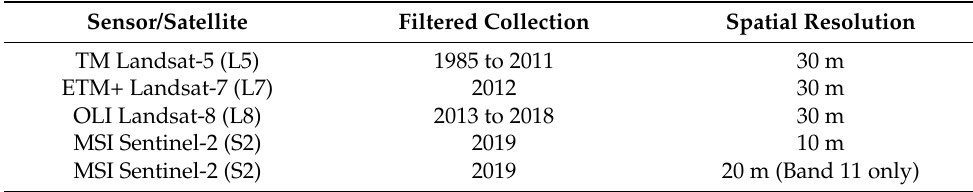
Table 3. Temporal coverage considered for Landsat (LS) and Sentinel-2 (S2) data.